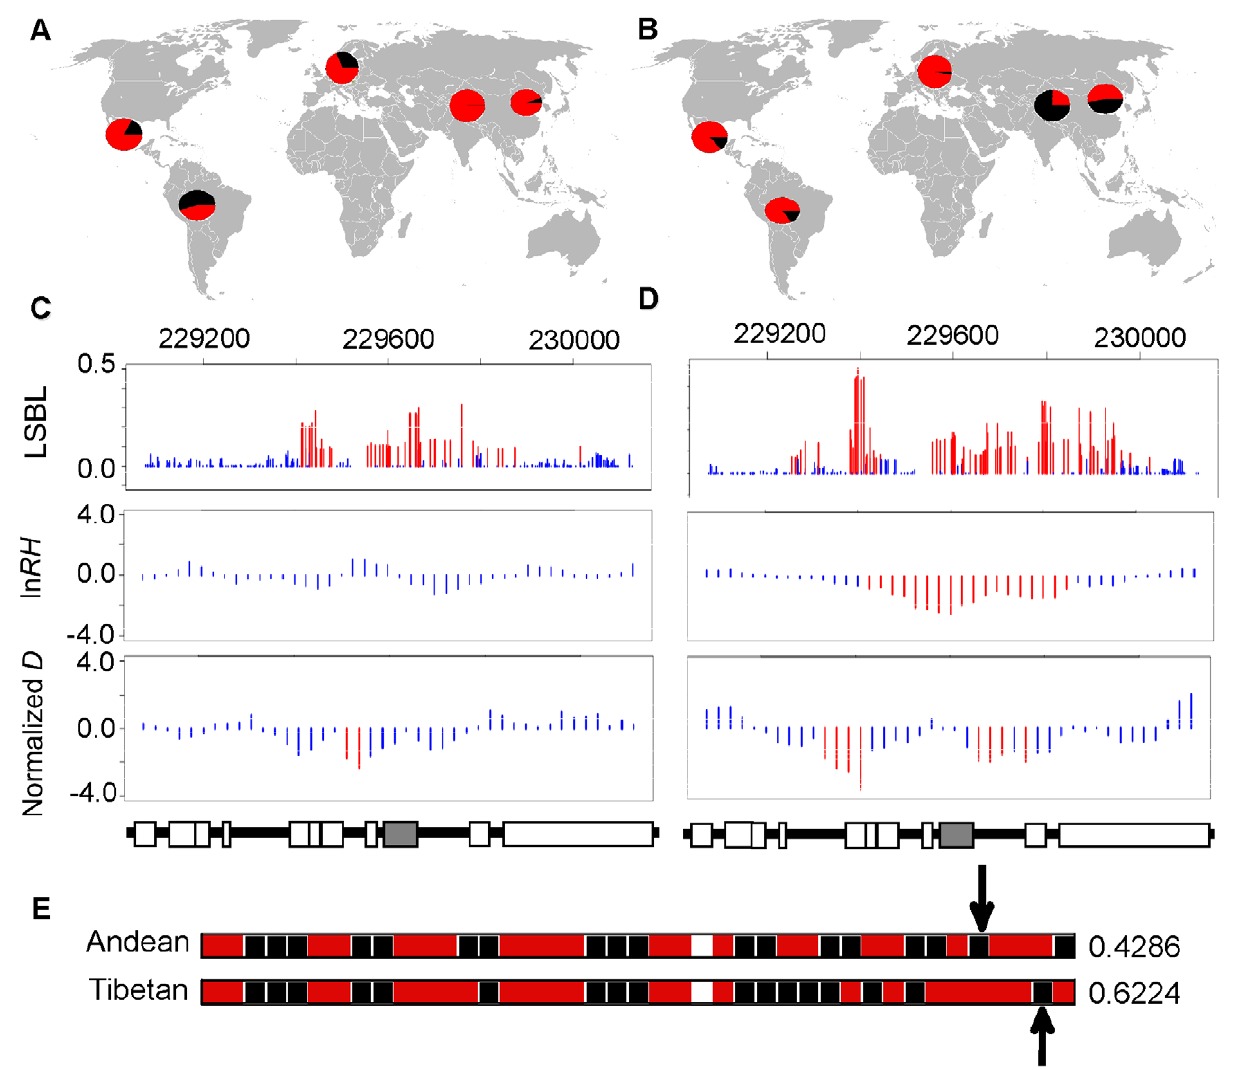
Figure 4. Genetic variation at EGLN1 . The distribution of allele frequencies is shown for the two EGLN1 SNPs, rs1769792 and rs12030600, exhibiting the highest ranked LSBL values in Andeans (A) and Tibetans (B), respectively. The derived G allele is shown red and the ancestral A allele is shown in black for rs1769792. The derived A allele is shown in red and the ancestral G allele is shown in black for rs12030600. LSBL, ln RH , and standardized difference of D are plotted for EGLN1 including 500 kb upstream and downstream from the gene in (C) Andeans and (D) Tibetans. Significant SNPs or sliding windows are shown in red (P E , 0.05) whereas non-significant SNPs or SNP windows are depicted in blue. The genes found in the plotted region are shown below the plots. EGLN1 is indicated in grey. The most frequent haplotype in the 100 kb region surrounding EGLN1 is depicted for Andeans and Tibetans (E). Ancestral alleles are depicted in black and derived alleles are depicted red. The ancestral/derived state for a single site is unknown and is depicted as an unfilled box. The population frequency is listed to the right of each haplotype. The arrows indicate the location of the SNPs displaying the most extreme LSBL values plotted in 4A and 4B.